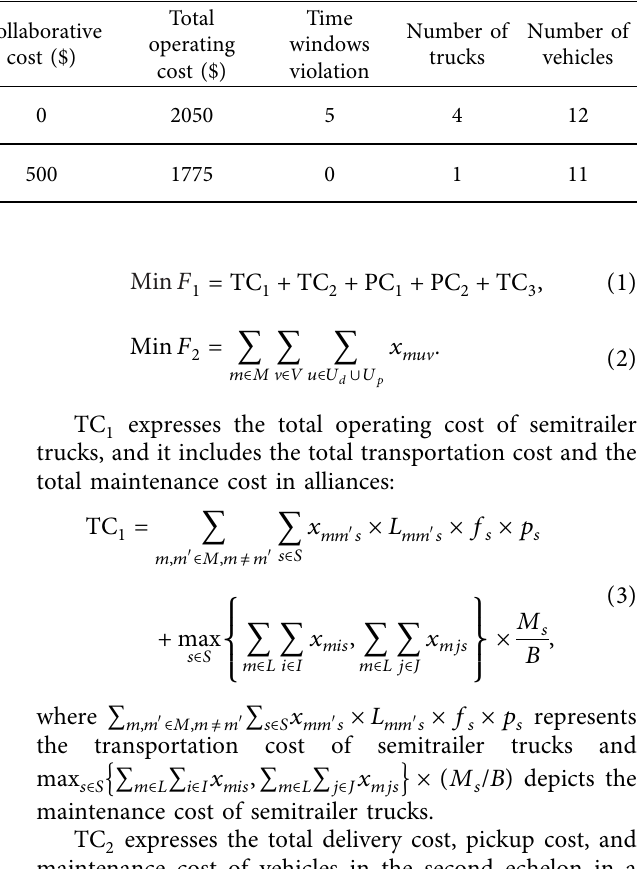
Table 2: Comparison before and after collaboration in the two-echelon pickup and delivery network.